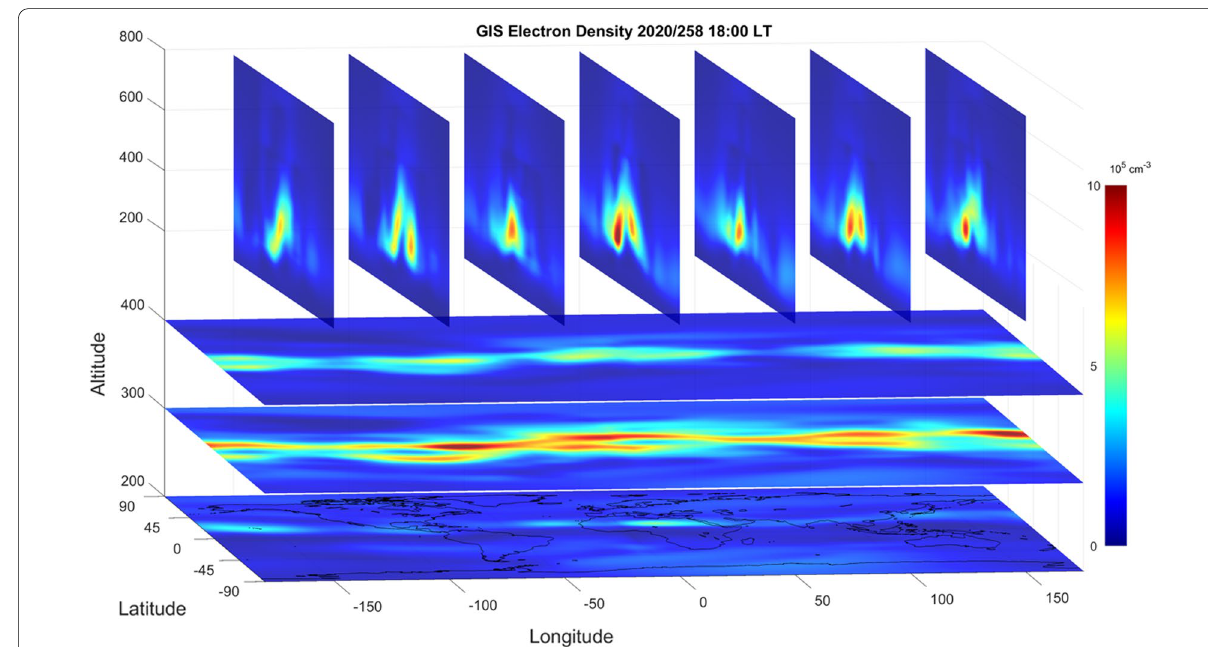
Fig. 13 The local time GIS electron density on 2020/09/14